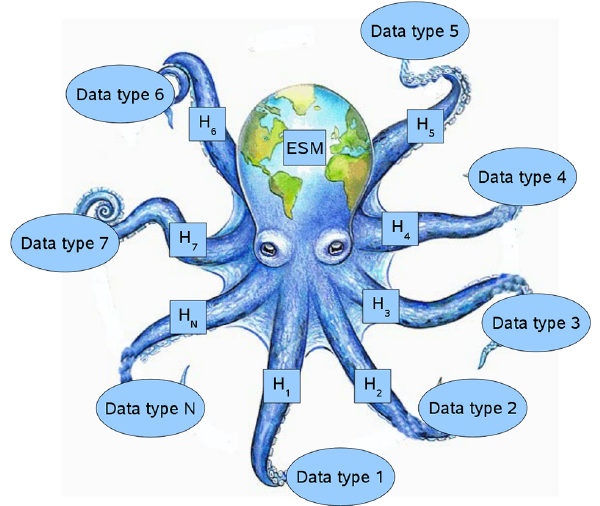
Figure 1. Schematic of an ESM assessing several data types via observation operators H 1 ,..., H n